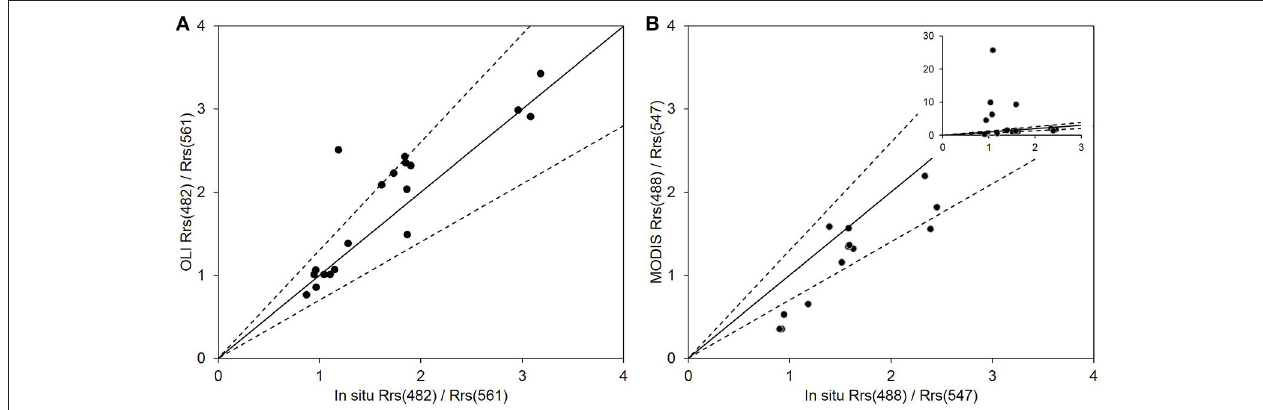
FIGURE 4 | Comparison between in situ and satellite-derived Rrs blue-green ratios. (A) OLI Rrs (482)/ Rrs (561) vs. in situ Rrs (482)/ Rrs (561). (B) MODIS Rrs (488)/ Rrs (547) vs. in situ Rrs (488)/ Rrs (547). The inset graph in panel (B) shows the full extent of MODIS data, indicating that several nearshore reflectance ratio values are significantly overestimated, a problem that is much less pronounced for the OLI data. The solid black line is the 1:1 line. Dashed lines are ± 30% from the 1:1 line.